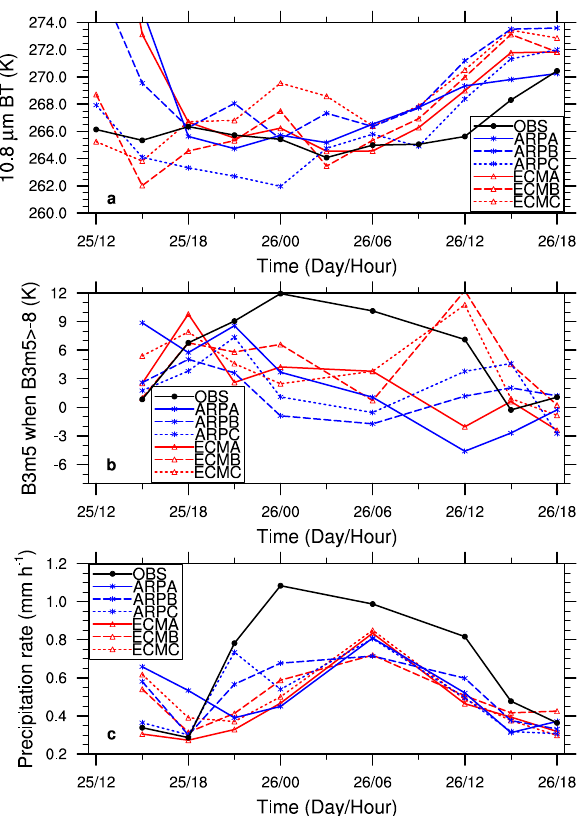
Fig. 4. Time series of mean (a) 10.8µm BT (K), (b) B3m5 (K) when B3m5 is larger than − 8 K, and (c) instantaneous precipitation (mm h − 1 ). Fields were averaged over the domain shown in Fig. 3.